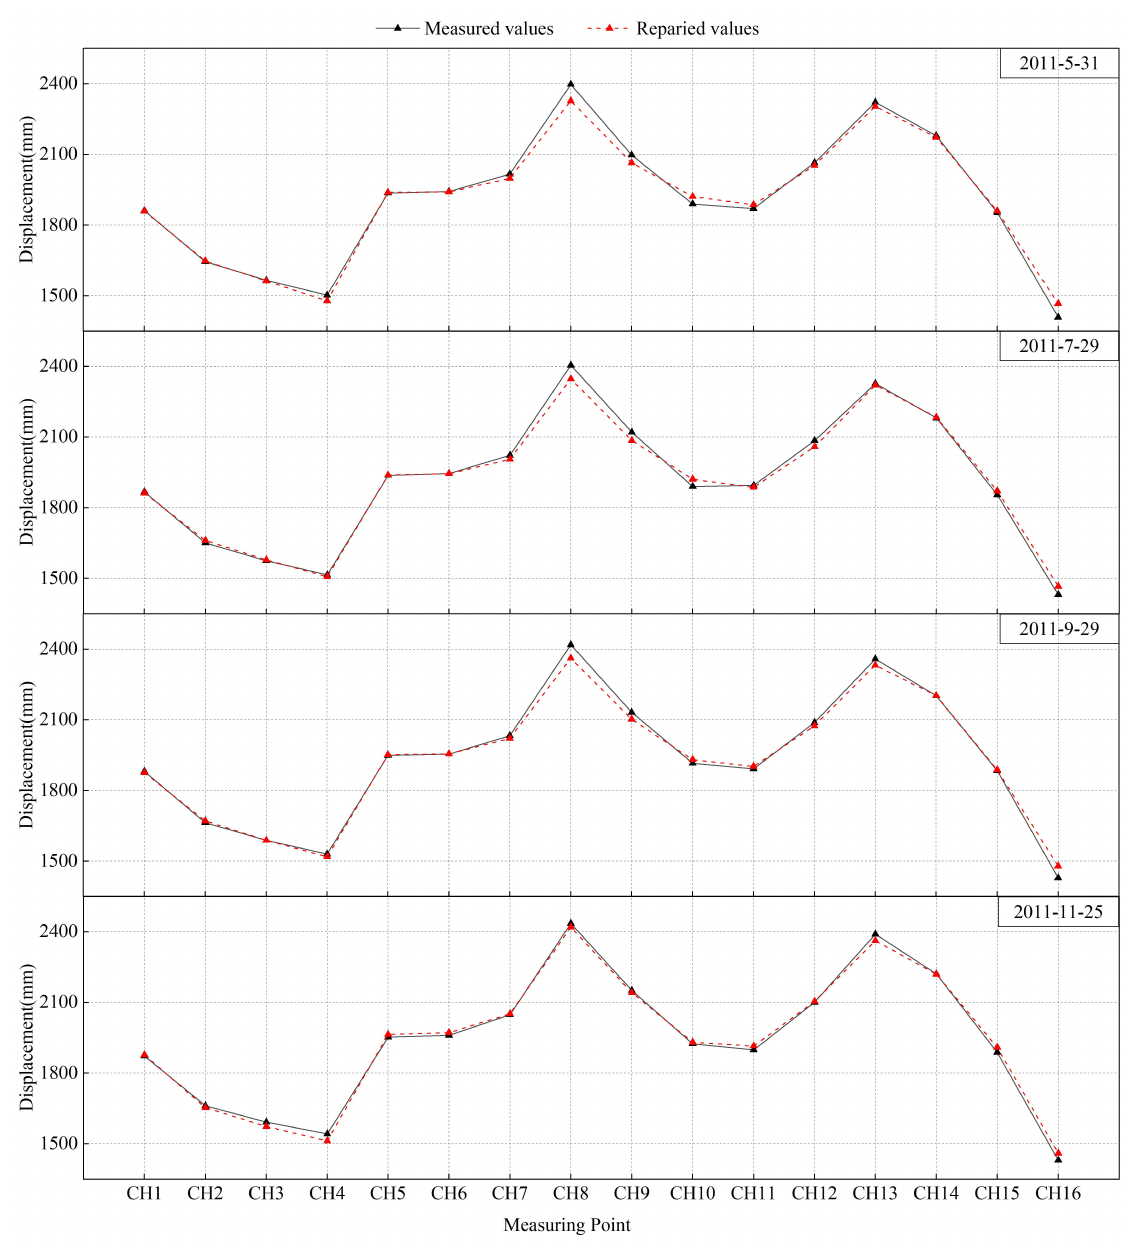
Figure 15. Cross-validation results of vertical